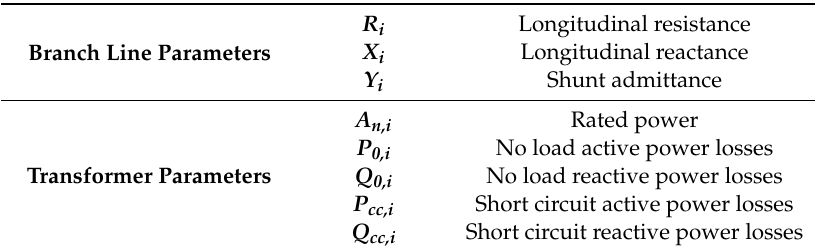
Figure 3. Scheme of the i -th brunch of the network model. Table 1. Required network parameters.